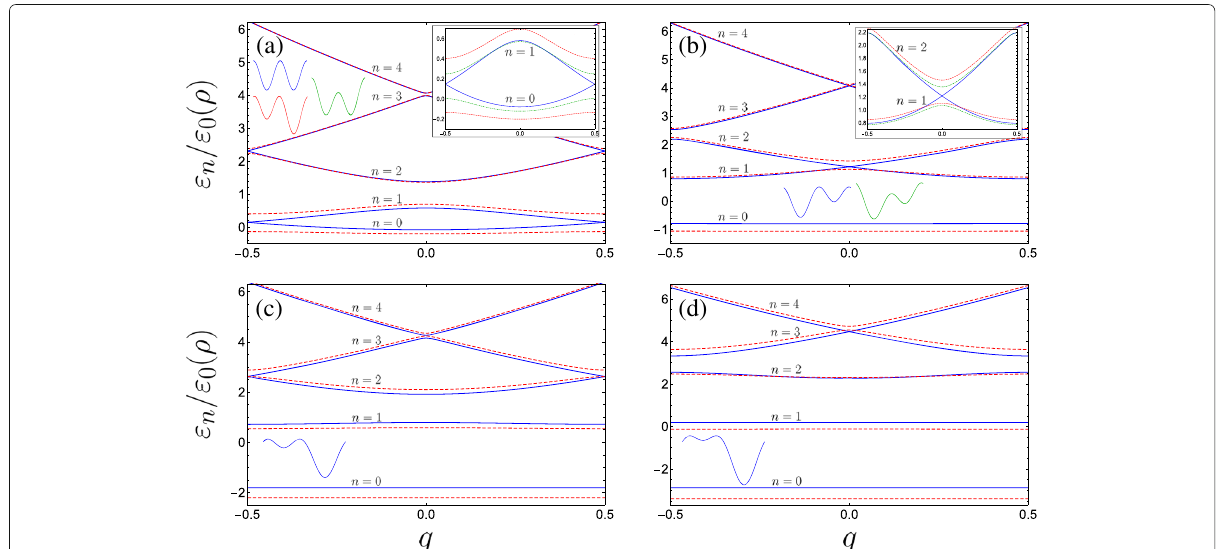
Fig. 3 Band structure for double-gated nanohelix system for various combinations of the dimensionless parameters (with B g = 0.4 fixed throughout): a Solid blue (dashed red) plots A g = 0 & C ⊥ = 0 ( A g = 0.2 & C ⊥ = 0), the inset additionally plots the behaviour of the bottom two subbands subject to the transverse electric field with A g = 0 & C ⊥ = 0.2 as the dot-dashed green curve. b Solid blue (dashed red) plots A g = 0.63 & C ⊥ = 0 ( A g = 0.8 & C ⊥ = 0) where the blue curve depicts the first incident of resonance (see text) with energy bands crossing at the centre of the Brillouin zone, the inset compares the behaviour of the bottom excited two subbands with the case where A g = 0.63 & C ⊥ = 0.2 as the dot-dashed green curve. c Solid blue (dashed red) plots A g = 1.26 & C ⊥ = 0 ( A g = 1.5 & C ⊥ = 0) where the blue curve depicts the second incident of resonance with energy gaps closing at the edge of the Brillouin for higher bands. d The third resonance and higher subband minigaps close at the centre, with solid blue (dashed red) being A g = 1.9 & C ⊥ = 0 ( A g = 2.2 & C ⊥ = 0). The unit cell shapes are sketched, n enumerates the bands, and the axis of the insets are the same as the main graphs